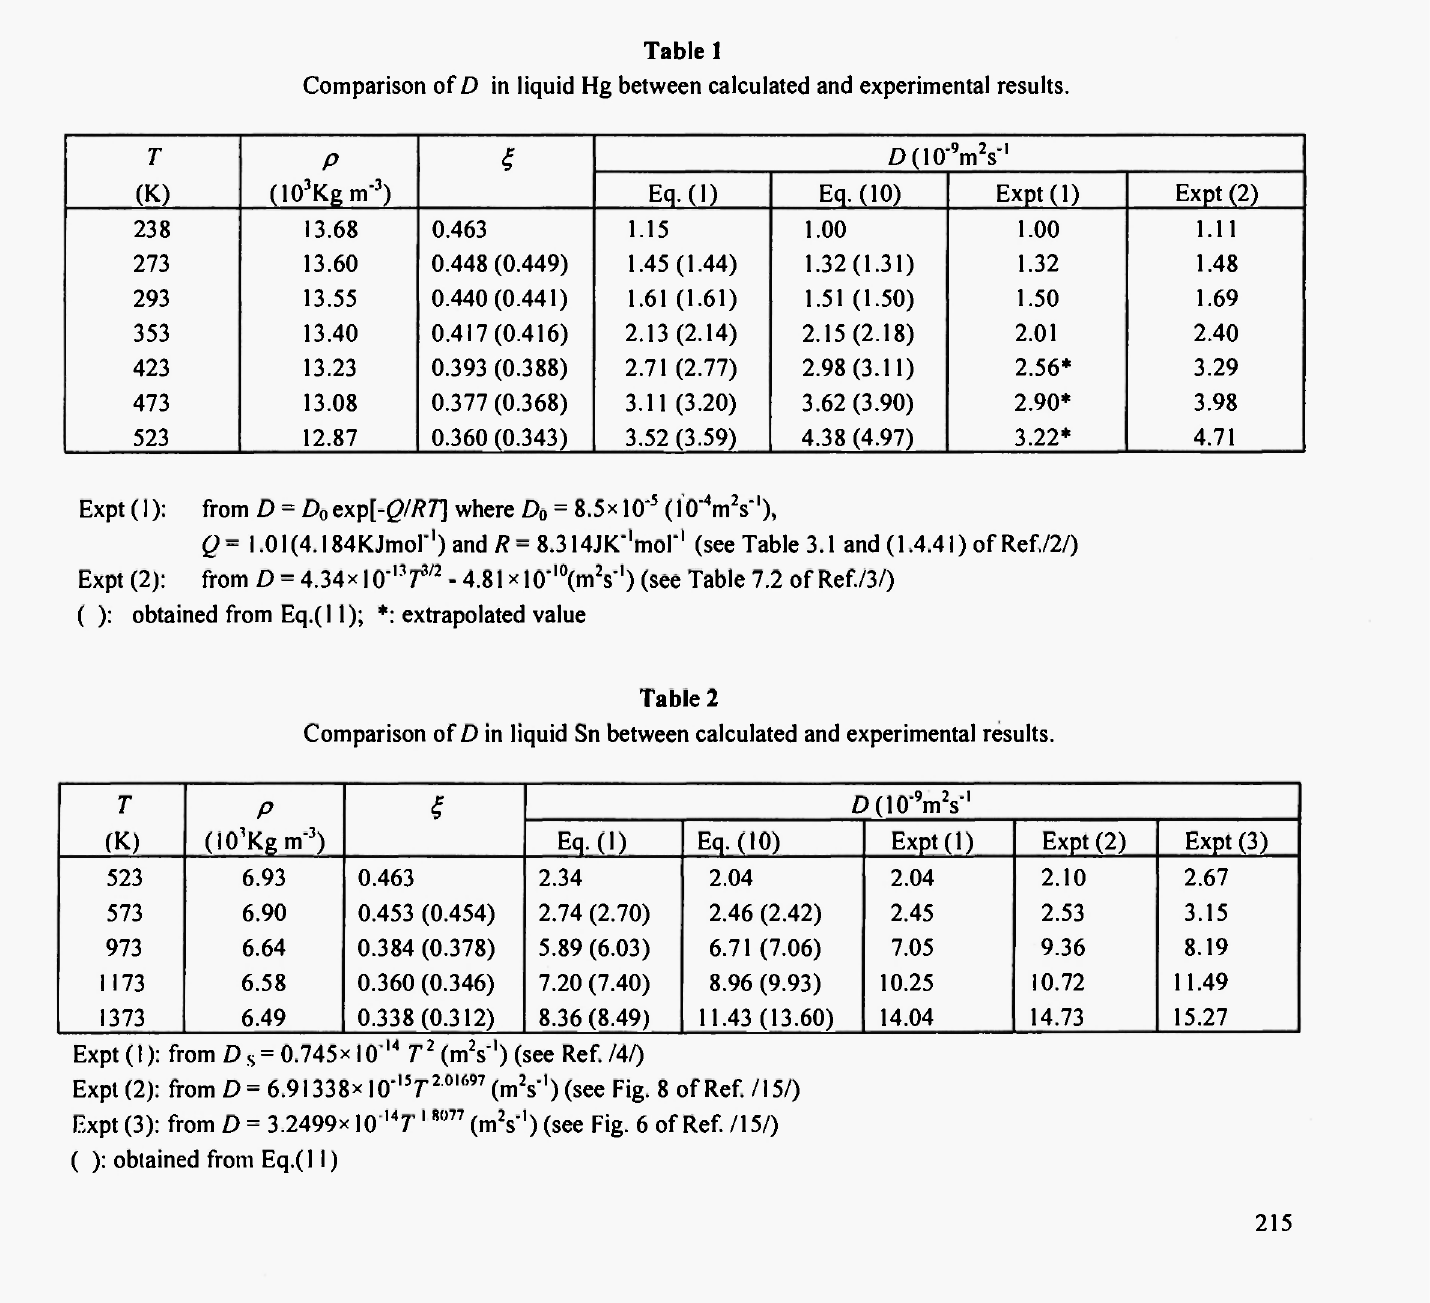
Comparison of D in liquid Hg between calculated and experimental results.